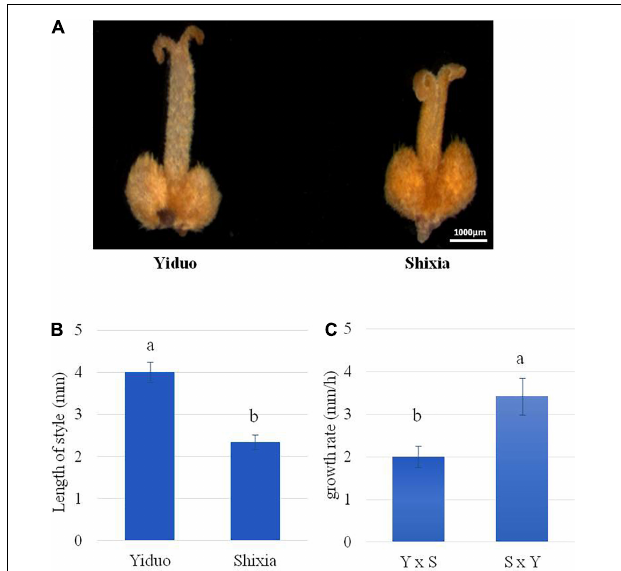
FIGURE 3 | Comparison of the pistil and pollen tube of longan with a stereomicroscope. (A) Observation of the pistil of Yiduo and Shixia with a stereomicroscope. (B) Length of the style in mm and (C) comparison of pollen tube growth rate in the two reciprocal crosses. Y, Yiduo; S, Shixia. Different letters show that the means differ significantly ( p < 0.05). Error bars represent the standard